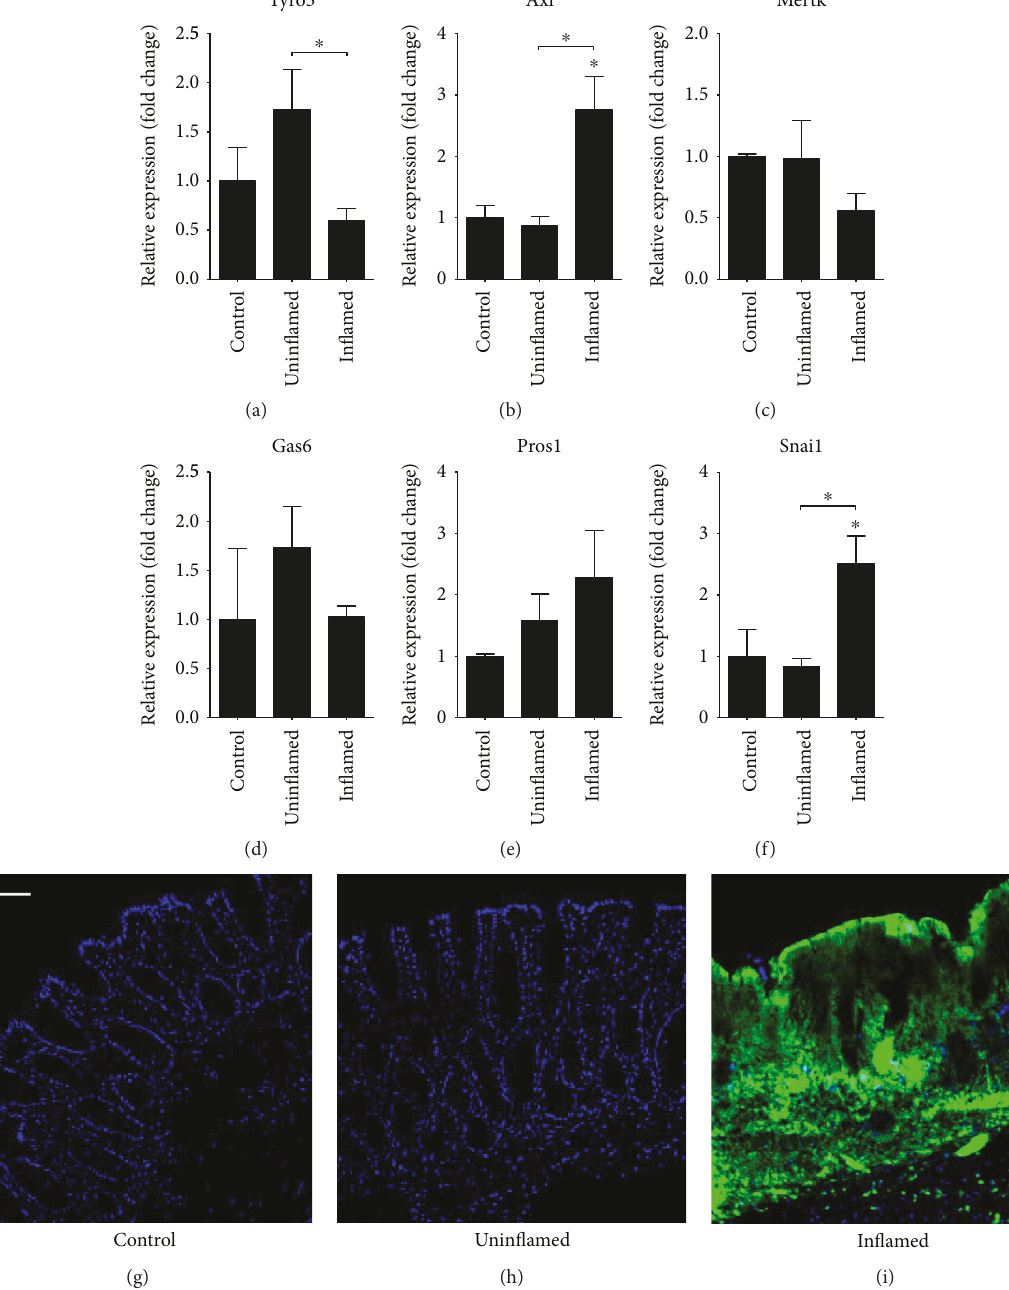
Figure 1: Diverse expression patterns of TAM receptors and their ligands at the site of colon in fl ammation in rat experimental colitis. The relative gene expression of TAM receptors Tyro3 (a), Axl (b), and Mertk (c) and their ligands Gas6 (d) and Pros1 (e) as well as the EMT- inducer Snai1 (f) is shown from control (left columns, n = 2 ), unin fl amed (middle columns, n = 6 ), and in fl amed (right columns, n = 6 ) rat colon sections. (g – i) Protein expression of Axl on rat colon sections. Data on (a – f) are presented as the mean ± SEM; ∗ p < 0 05 . Scale bar for (g – i): 100 μ m; blue: DAPI; green: Axl